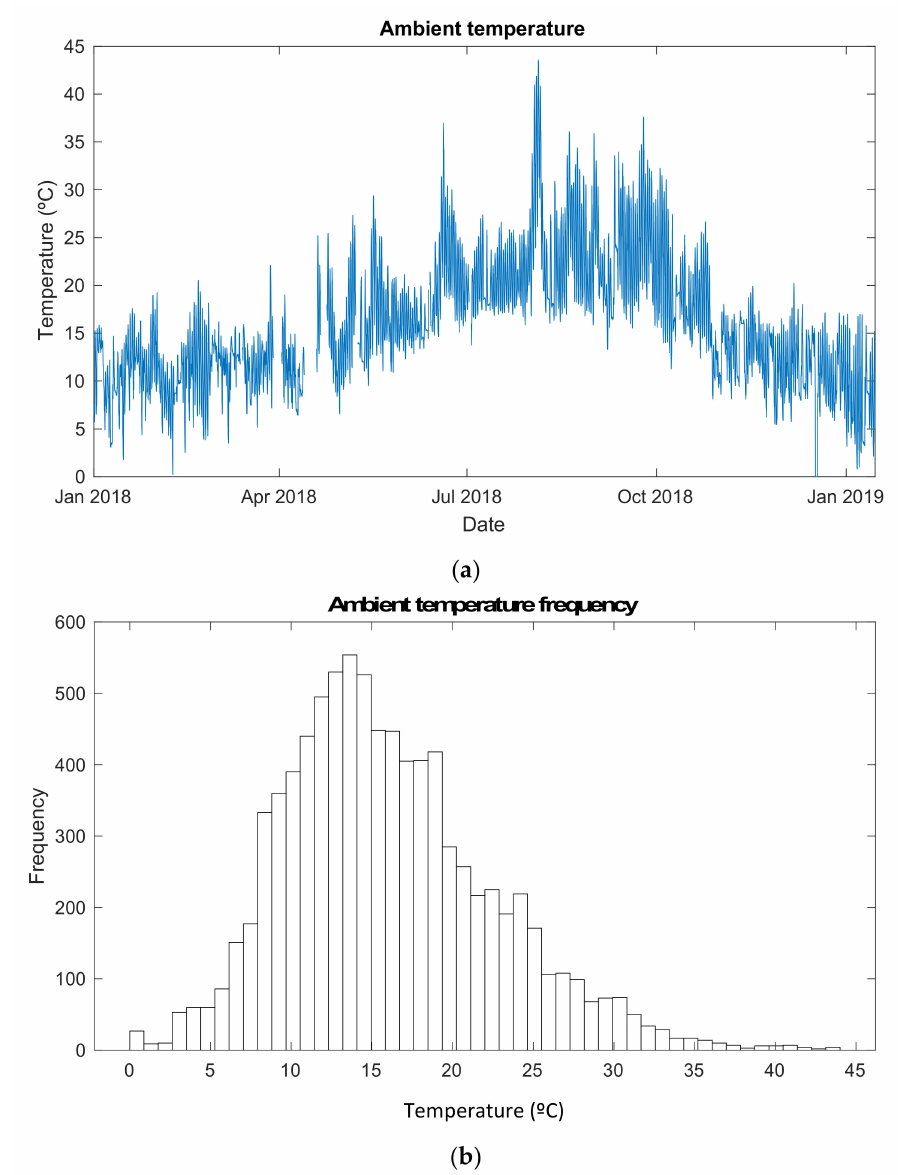
Figure 4. ( a ) Ambient temperature; ( b ) ambient temperature